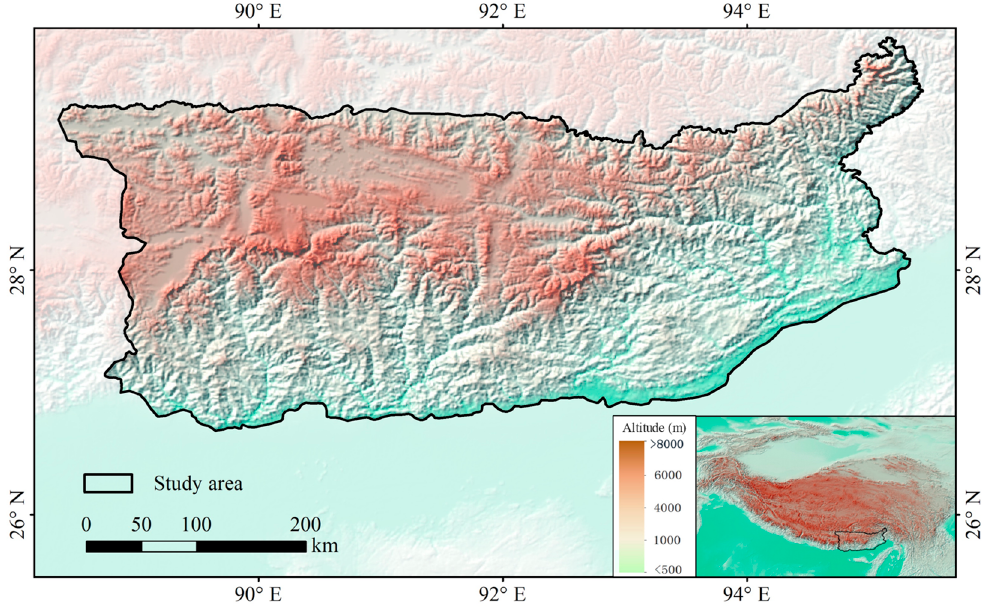
Figure 1. The geographic extent and topographical distribution of the study area.